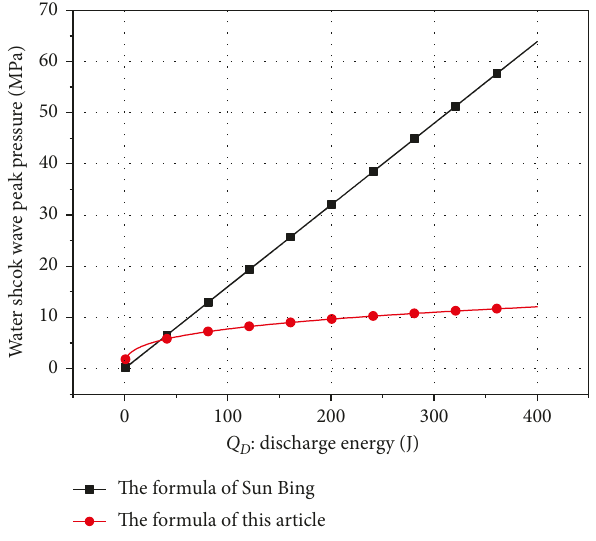
Figure 11: Comparison diagram showing the discharge energy ( Q D ) versus water shock peak pressure using Sun Bing’s formula and